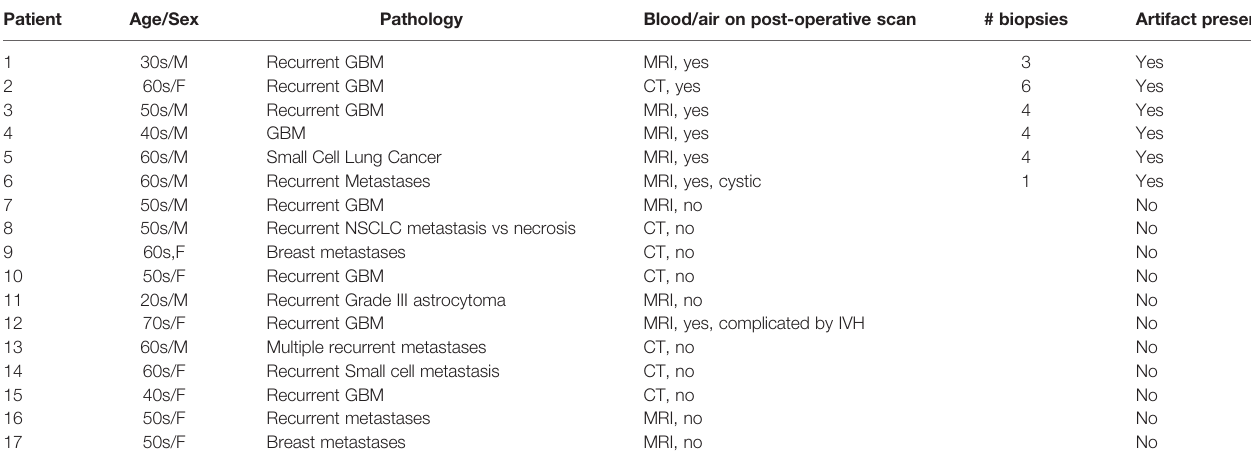
TABLE 1 | Patients who underwent LITT for brain tumor ablation, with or without preceding biopsy.